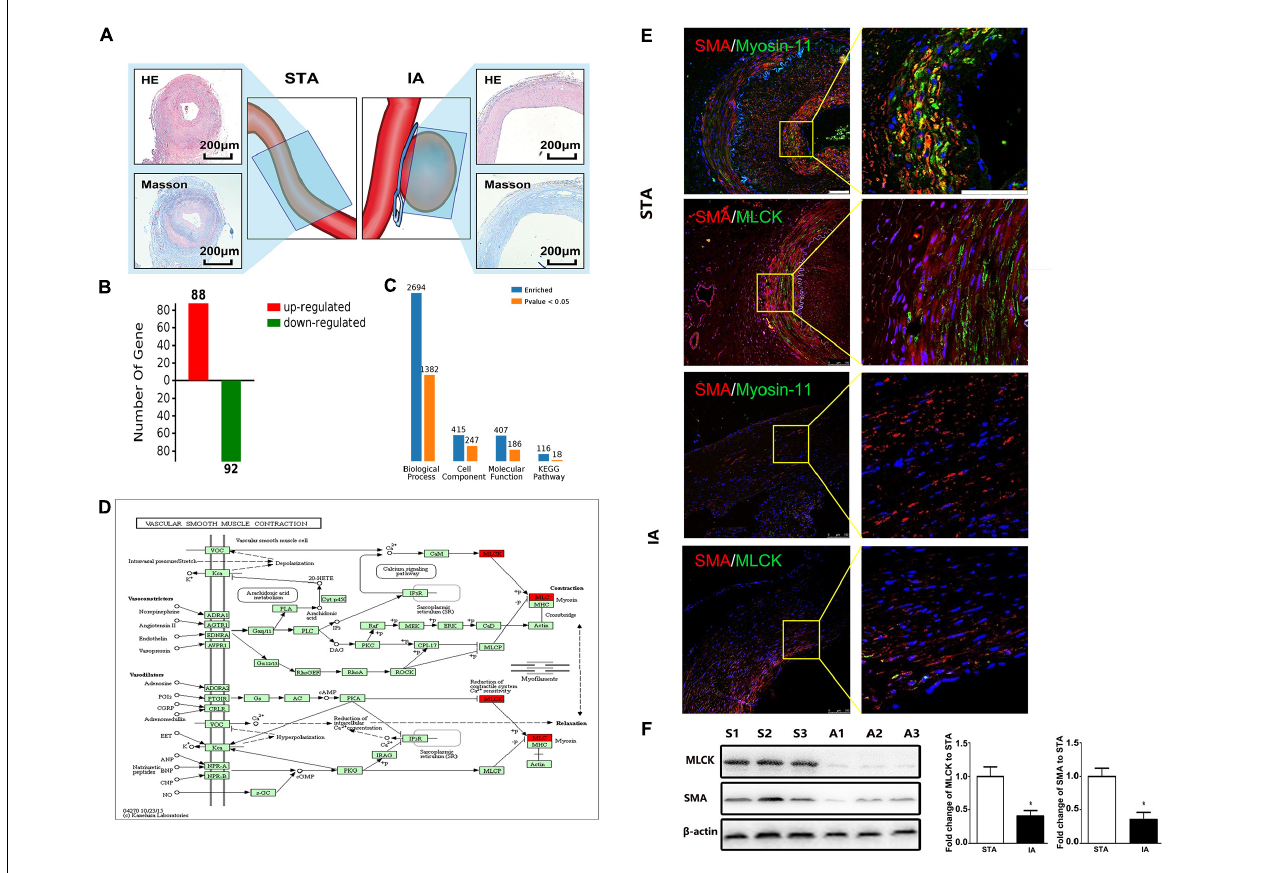
FIGURE 1 | Basic information from label-free proteomics and verification in tissue samples. (A) IA and STA illustration with HE and Masson staining show the specimen location for label-free proteomics. (B) Significant differences in protein levels between IA and STA. (C) GO ontology analysis between IA and STA. (D) KEGG pathway mapping of smooth muscle cells (SMCs). (E) Double staining for SMA/myosin-11 and SMA/MLCK in STA and IA, with 2 × magnification for a closer view. (F) Western blot and quantification studies of MLCK and SMA in the tissue sample. S1–S3 represents proteins from three different STA samples, and A1–A3 represents IA samples. STA, superficial temporal artery; IA, intracranial